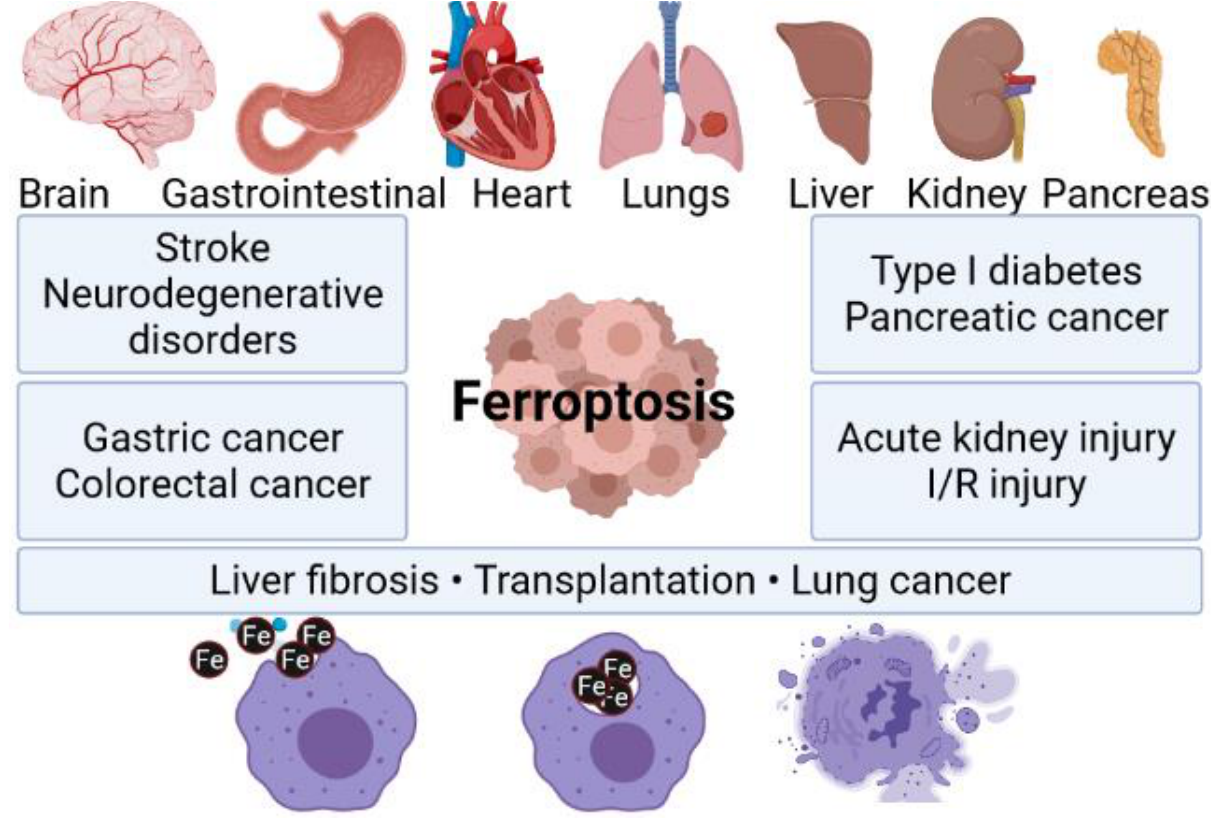
Figure 1. Ferroptosis as a factor triggering failure of multiple organs. Composed with BioRender [21].